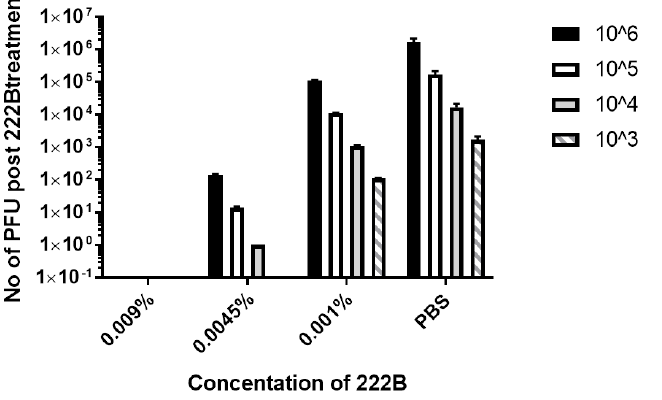
Figure 7. Plaque reduction of 222B against HSV-1. HSV-1 stock at ~2 × 10 7 PFU/mL was diluted to ~2 × 10 6 PFU/mL (solid bar), ~2 × 10 5 PFU/mL (open bar), ~2 × 10 4 PFU/mL (grey bar), ~2 × 10 3 PFU/mL (stripped bar) in PBS containing 222B at 0.009%, or 0.005%, or 0.001% in the final concentration, respectively. The diluted viruses were then titrated in a 12-well plate seeded with Vero cells. Plaque formation was quantified at 4–5 dpi and expressed as average PFU post 222B treatment ( n = 3).